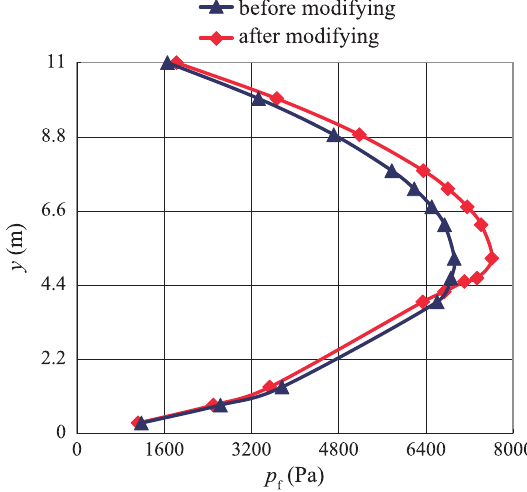
Fig. 8 The friction stress distribution curve.